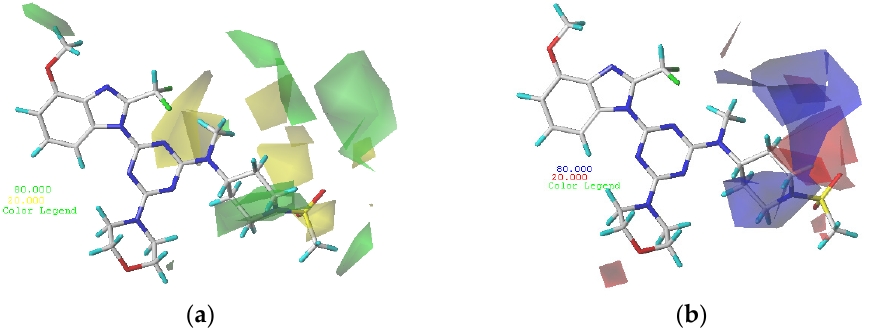
Figure 2. Contour maps of compound 29 . ( a ) Steric contour maps of CoMFA: favored (green) and disfavored (yellow); ( b ) electrostatic contour maps of CoMFA: electrostatic (blue) and electronega- tive (red).